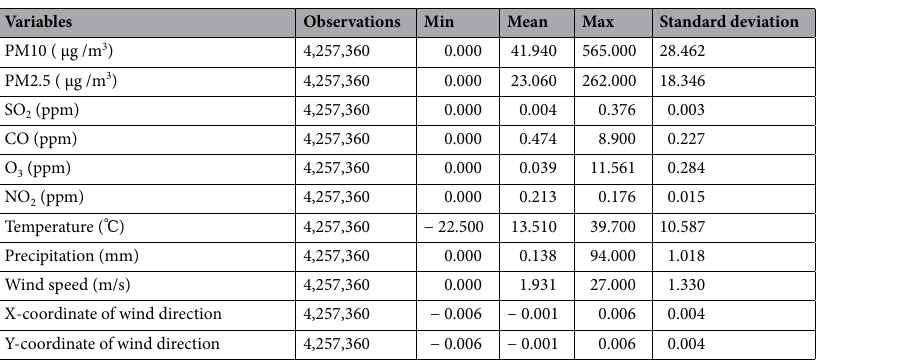
Figure 2. Visualization of air quality and weather monitoring stations. Map image is obtained from OpenStreetMap (openstreetmap.org) and licensed under CC-BY-SA (https:// www. opens treet map. org/ copyr ight).